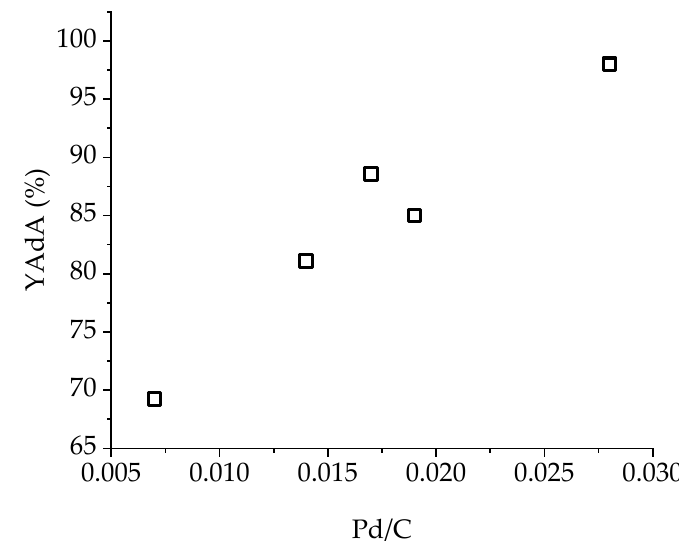
Figure 11. Influence of Pd / C ratio on YAdA (after 30 min of reaction) during t,t-MA hydrogenation with Pd / KB catalyst series.